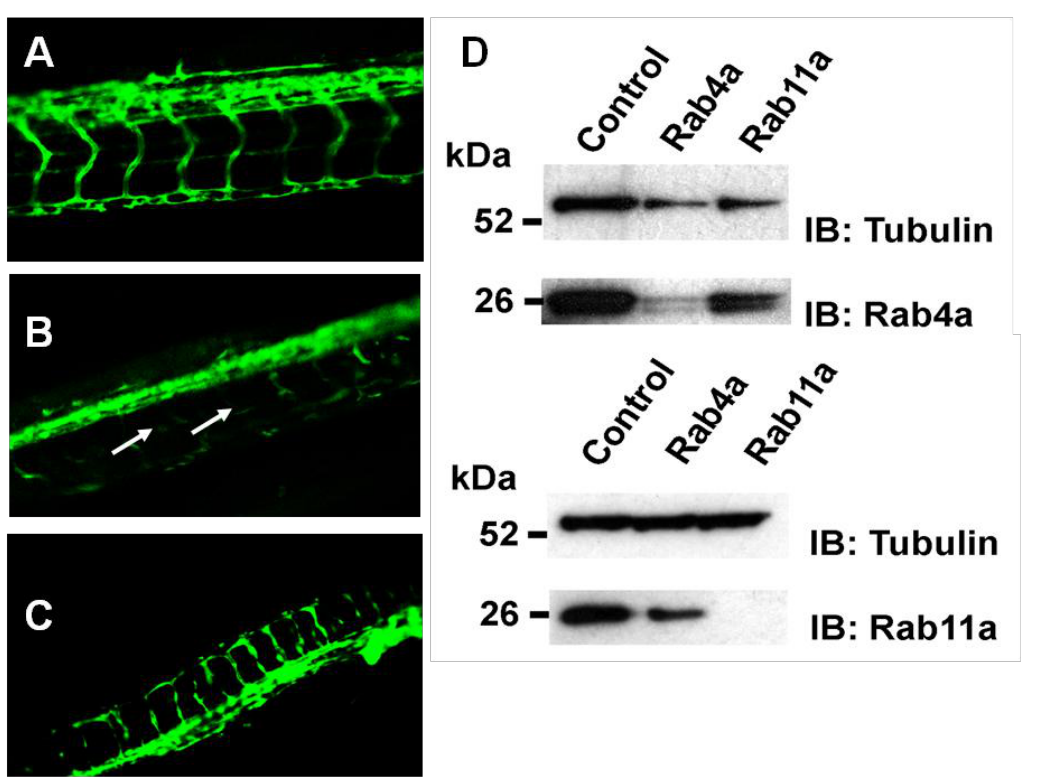
Figure 8. Rab4a regulates vascular development in transgenic zebrafish.